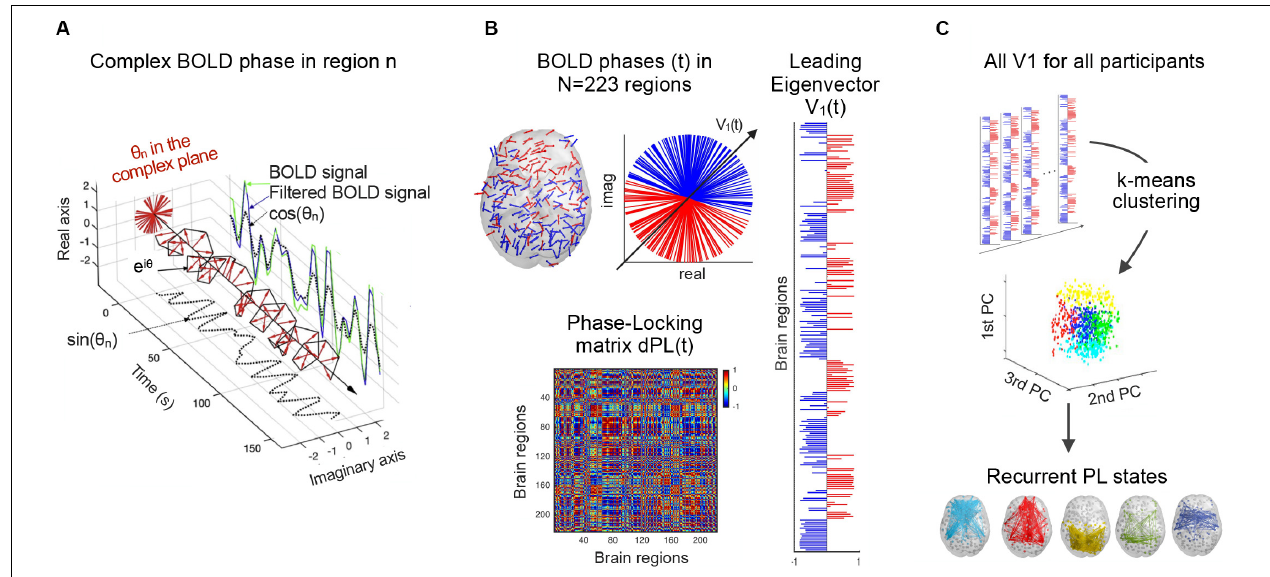
FIGURE 1 | Detection of recurrent BOLD PL patterns. (A) For a given region, the BOLD signal (green) is first band-pass filtered between 0.01 and 0.1 Hz (blue) and then Hilbert transformed into an analytic signal, whose phase can be represented over time by e i θ (black line) and at each TR (red arrows). (B) At a single time point, BOLD phases in all N = 223 regions can be represented in cortical space (left) and the complex plane (middle). The dPL(t) matrix captures the phase alignment between each pair of regions (bottom). The leading eigenvector of the dPL(t) matrix, V(t), is the vector that best captures the main orientation of all phases, where each element in V(t) corresponds to the projection of the phase of each region into V(t) (right). (C) All the leading eigenvectors V(t) are concatenated over participants and fed into a k-means clustering algorithm, which divides the pool of data points into a predefined number of clusters k. Each cluster centroid represents a recurrent PL state. dPL, dynamic